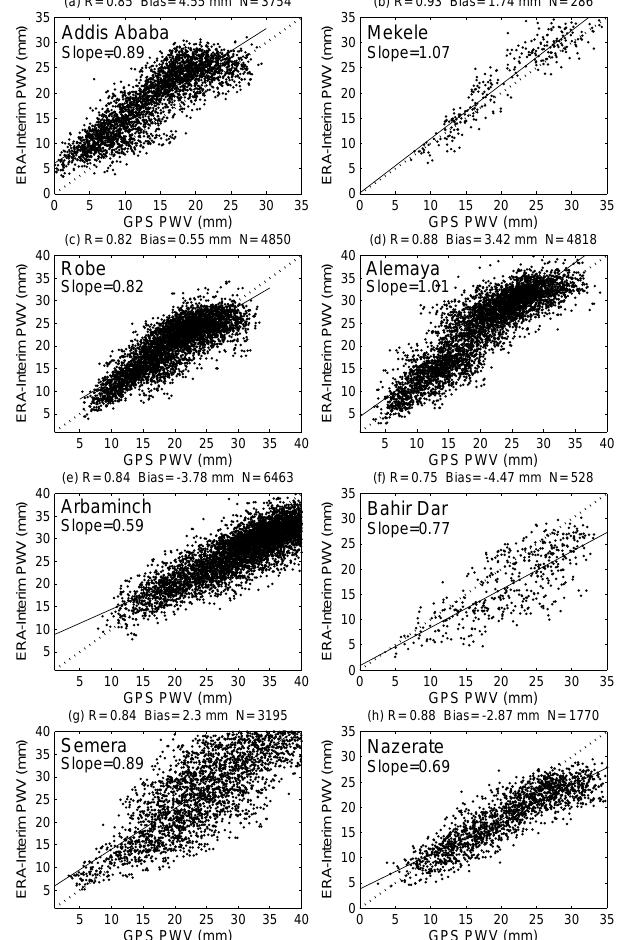
Figure 8. Comparison of GPS and ERA-Interim PWV at eight sites. Each site is shown at the top-left corner of each panel for in Ethiopia. The slope of the solid line from the linear fit is also in- dicated on each